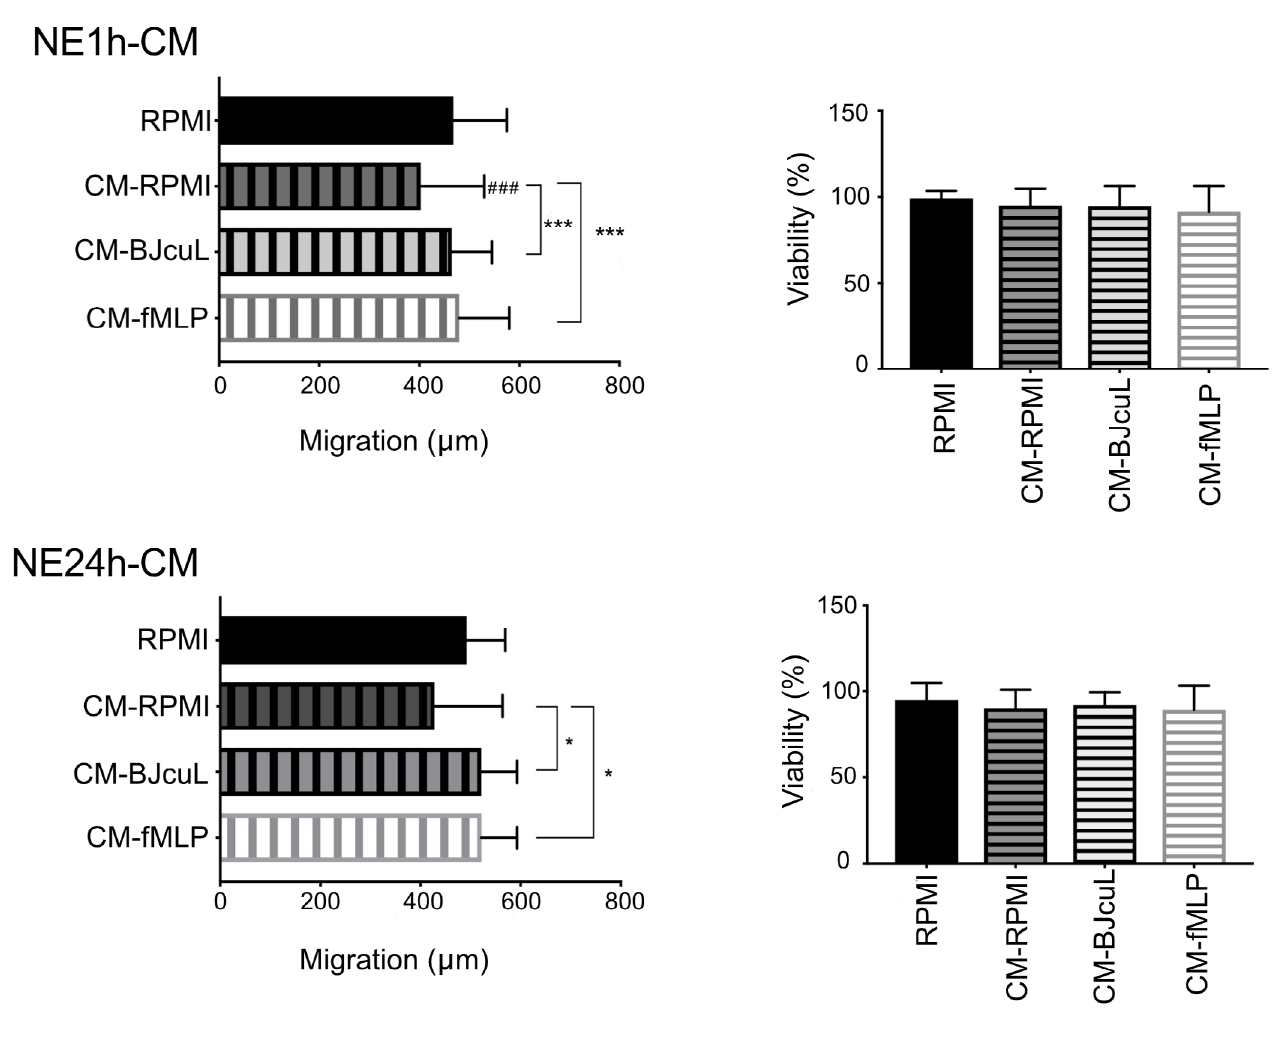
Figure 2. Analysis of migration and viability of SK-N-SH incubated with neutrophil conditioned media (CM). NB cells (1x10 6 cell/mL) were incubated for 24 h in a 24-well plate (300 µL/well) with 1:2 (v/v) neutrophil-conditioned media (CM). CMs were generated by culturing neutrophils in RPMI, 2.5 µg/mL BJcuL or 10 µM fMLP for 1 h (NE1h-CM) or 24 h (NE24h-CM). Quantitative results are represented as means ± standard deviation (SD) of the migration distance (µm), determined as the difference in wound width at T0 and T48 (T0-T48; n = 12). After the completion of the migration assay, the viability assay of the NB cells in each condition was established. Viability results are represented as mean ± SD (n = 10) of viable cells normalized to the untreated control (RPMI). Data were obtained from at least three independent assays. Statistical analysis was performed by one-way ANOVA and Tukey’s test with significance reported as *p < 0.05; **p < 0.005 and ***p < 0.001. # indicates difference comparing with RPMI